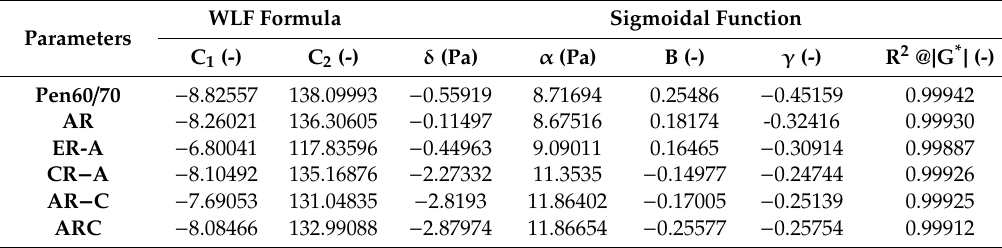
Table 4. Model parameters of the WLF formula and sigmoidal function.